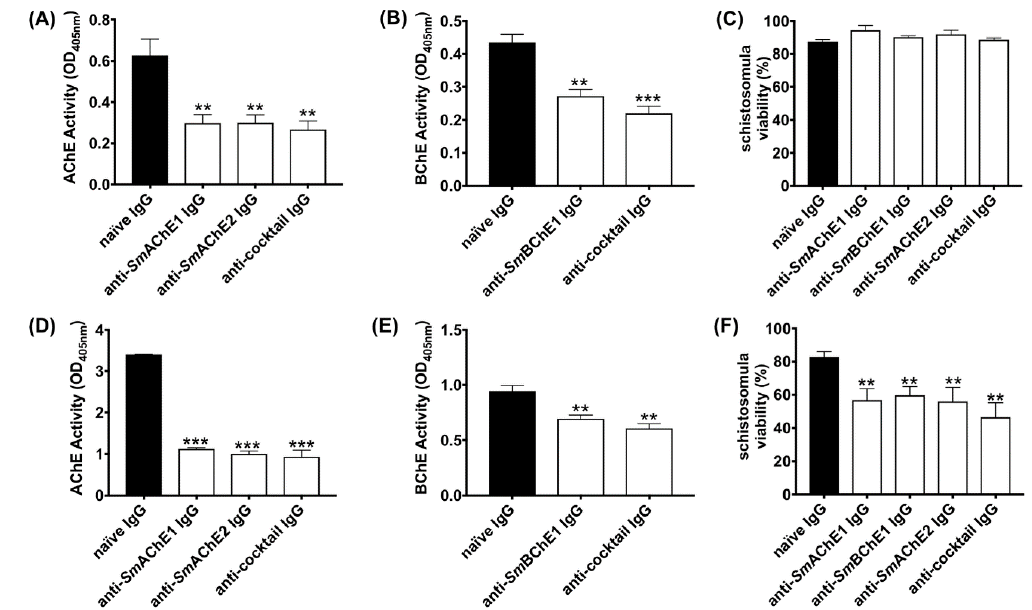
Figure 1. Anti-schistosome cholinesterase ( Sm ChE) antibodies inhibit ChE activity in schistosomula, which leads to a decreased parasite viability. Newly transformed schistosomula (1000/treatment) were incubated in Dulbecco’s Modified Eagle Medium (DMEM) in the presence of anti- Sm ChE IgG and incubated at 37 ° C in 5% CO 2 . Naïve IgG served as a negative control. ( A ) AChE activity 2 h after treatment. ( B ) BChE activity 2 h after treatment. ( C ) Schistosomula viability 2 h after treatment. ( D ) AChE activity 14 h after treatment. ( E ) BChE activity 14 h after treatment. ( F ) Schistosomula viability 14 h after treatment. Data represents the mean ± SEM of two biological and three technical replicates. Significance (relative to the naïve IgG control) determined by the student’s t test, where ** p ≤ 0.01 and *** p ≤